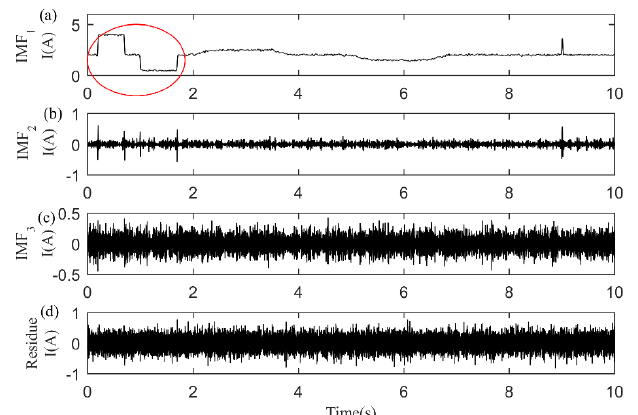
Figure 12. VMD decomposition diagram under the noise of SNR 10. ( a ) IMF 1 component; ( b ) IMF 2 component; ( c ) IMF 3 component; ( d ) Residue.